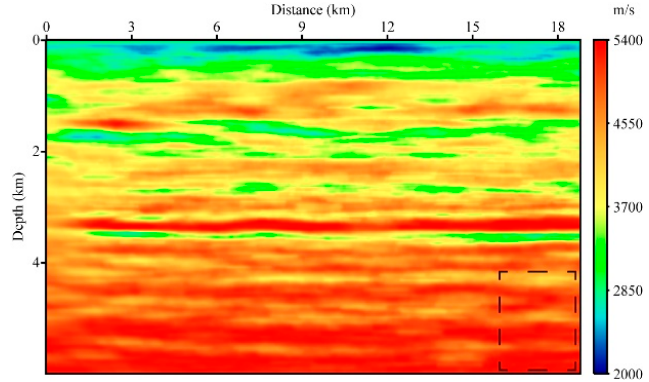
Figure 13. P-wave velocity.